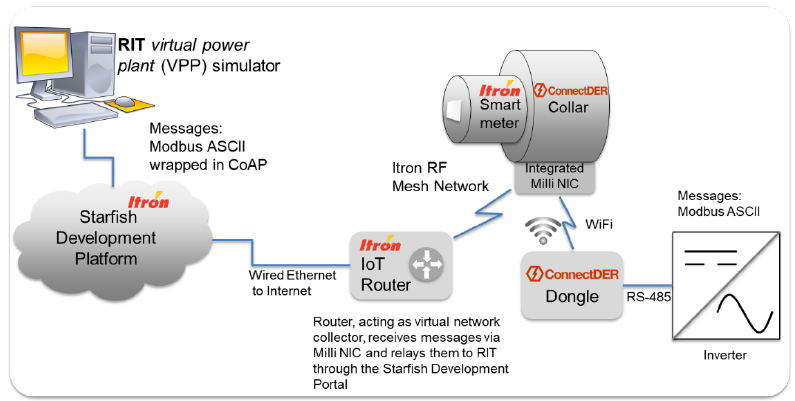
Figure 1. Block diagram of the system-level